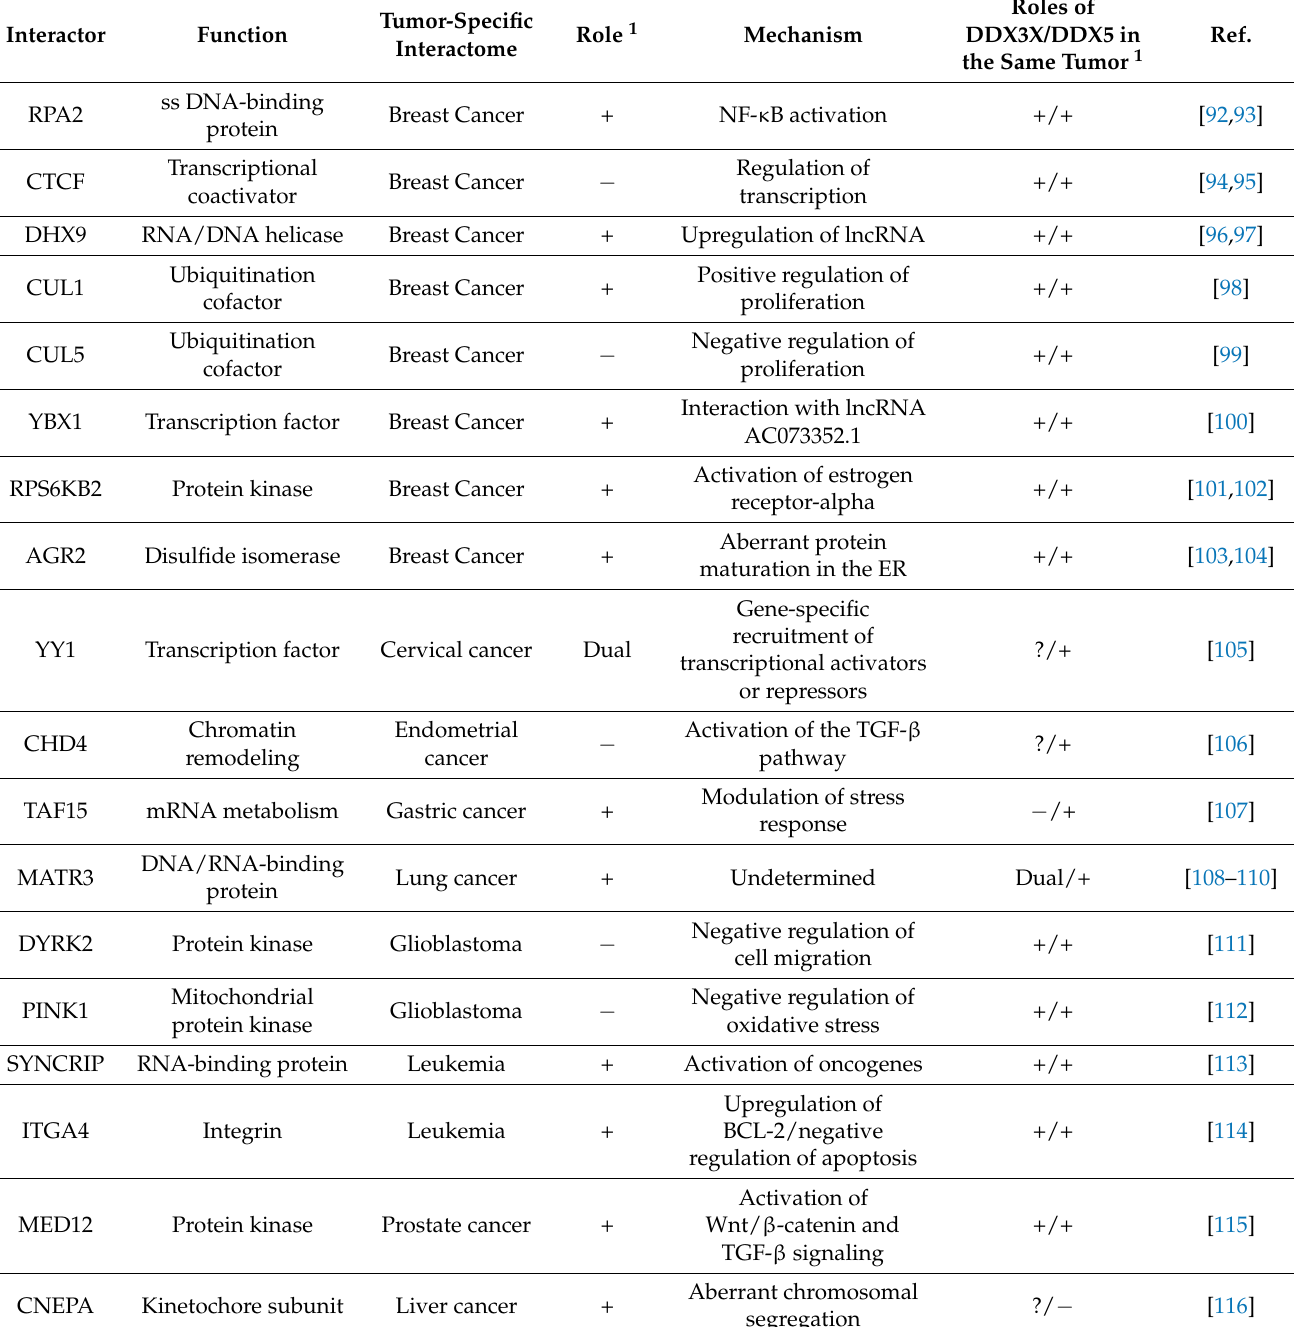
Table 3. Selected common interactors of DDX3X and DDX5 and their roles in